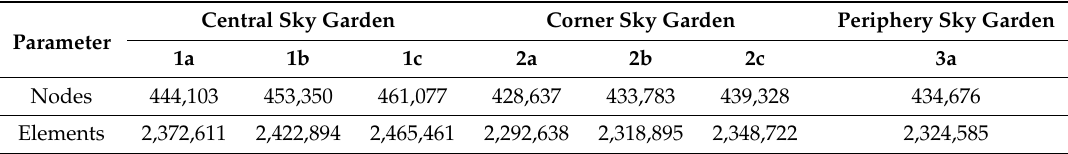
Table 3. Computational mesh size implemented for the sky garden model.